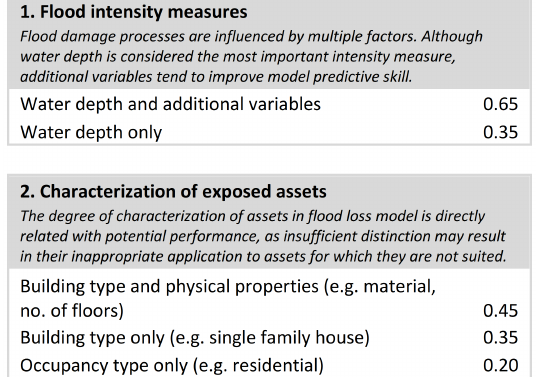
R. Figueiredo et al.: Multi-model ensembles for assessment of flood losses and associated uncertainty tive categories are defined (e.g. relative and absolute).